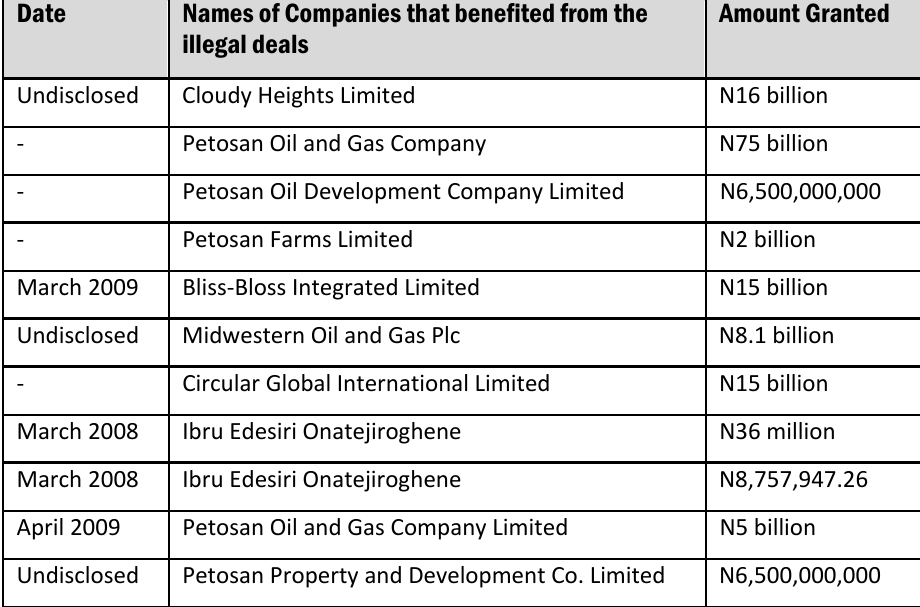
Table 1: Credit Facilities Granted to Companies without